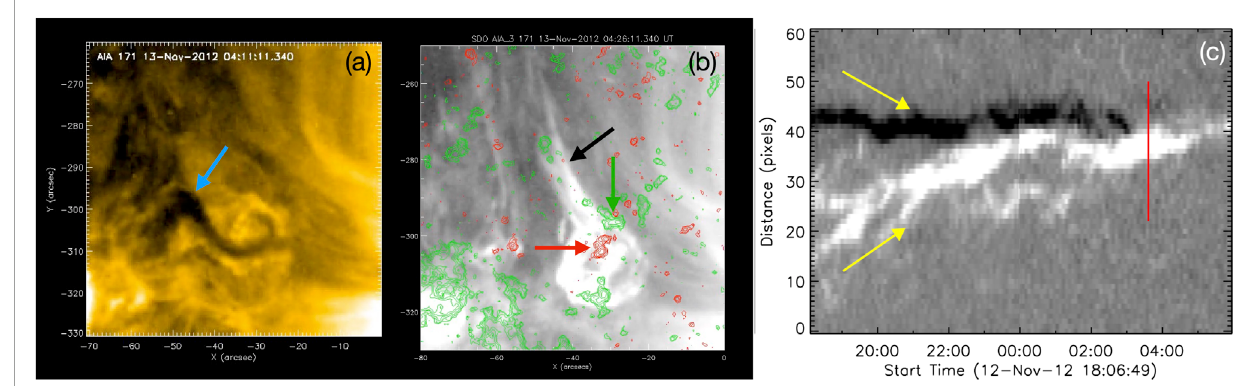
FIGURE 3 Observations of a coronal jet originating from an on-disk location, on 2012 November 13, from Panesar et al. (2016b). Panel (A) is an SDO /AIA 193Å image, showing a minifilament (blue arrow) starting to erupt to produce the coronal jet. Panel (B) shows an AIA 193Å image (grey scale) 15 min later, where the minifilament has erupted and generated the coronal jet, with the black arrow pointing to the spire. Overlaid is magnetic flux from an SDO /HMI magnetogram, with red/green contours indicating positive/negative polarities. Red and green arrows point to two polarity elements highlighted in the next panel. Panel (C) shows the time evolution of those positive-polarity (white) and negative-polarity (black) fluxes in a time-distance map, with the vertical red line indicating the time of coronal-jet occurrence. This shows the polarities converging and undergoing cancelation near the time of the coronal-jet’s